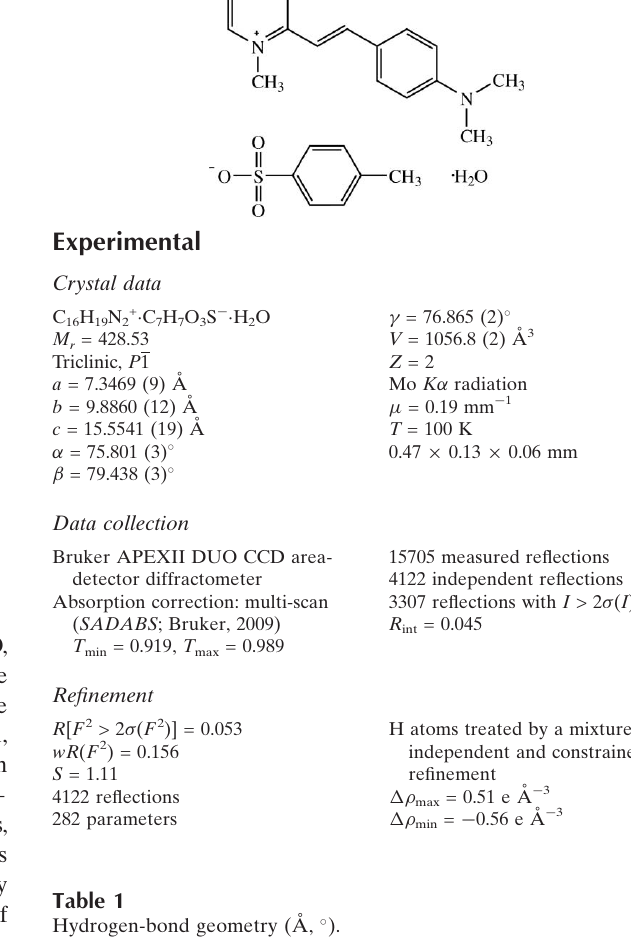
Hydrogen-bond geometry (A˚ , (cid:4) ). D —H (cid:2)(cid:2)(cid:2)